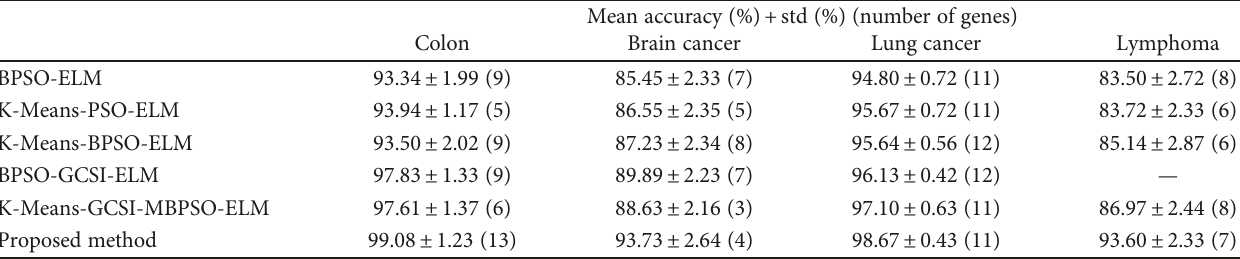
Figure 8: Road roughness estimation results based on the random forest method and features in Experiment Table 6: Comparisons between proposed feature dimensionality reduction method and six other methods.